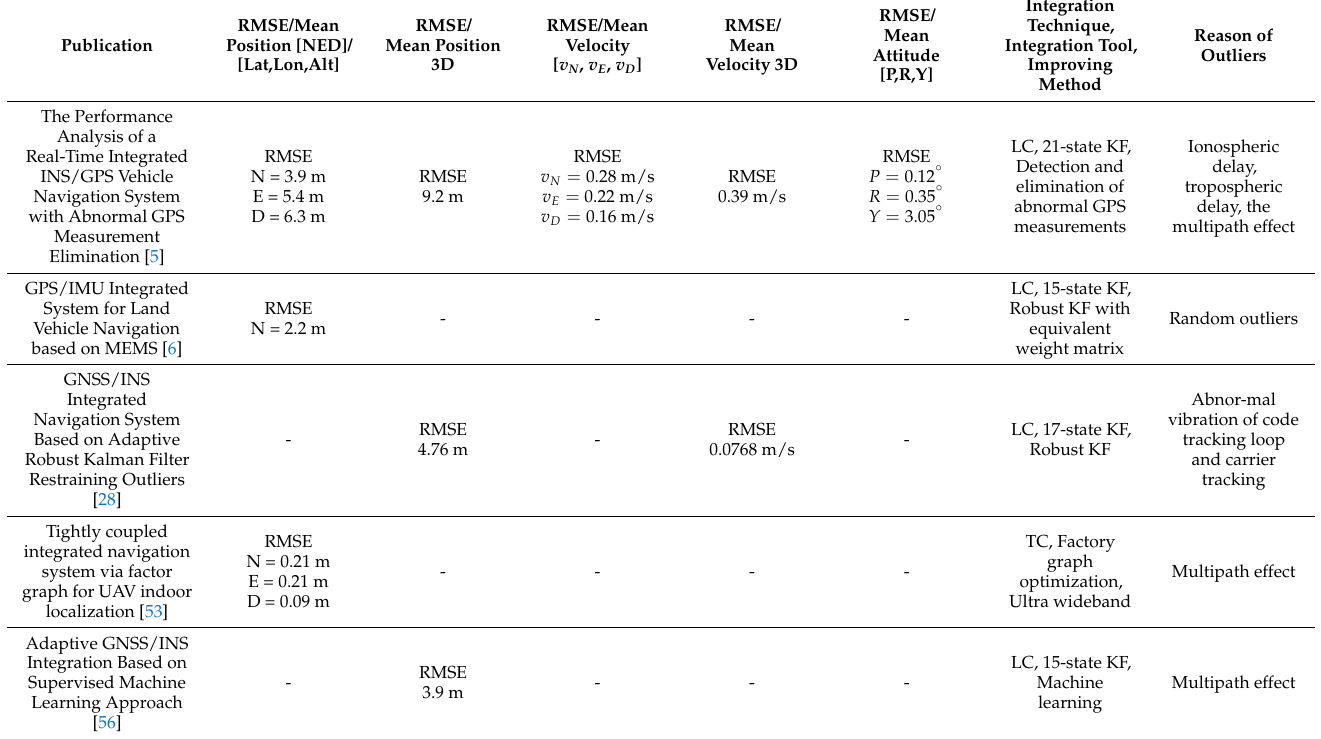
Table 4. Comparative characteristics of various approaches to the implementation of integrated INS/GNSS systems in the presence of outliers and violation of